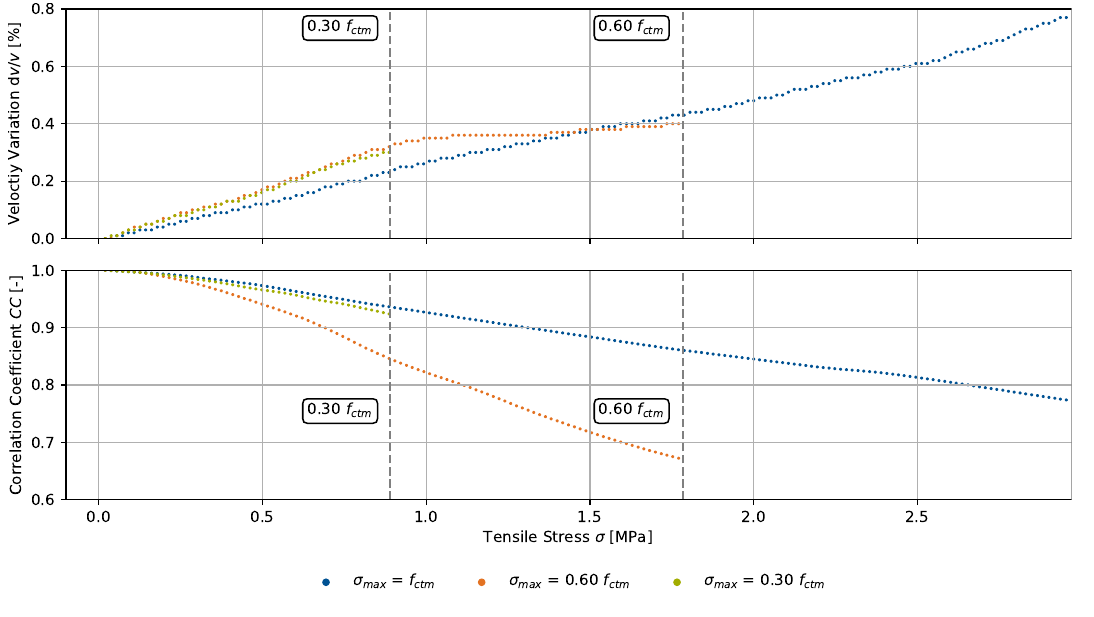
Figure 10. Velocity variation dv / v and signal correlation coefficient CC , both using a fixed reference signal at an unloaded state, for three specimens as in Figure 9, translated into the tensile stress domain during the loading process up to 100% (failure), 60%, and 30% of the compressive strength f ctm